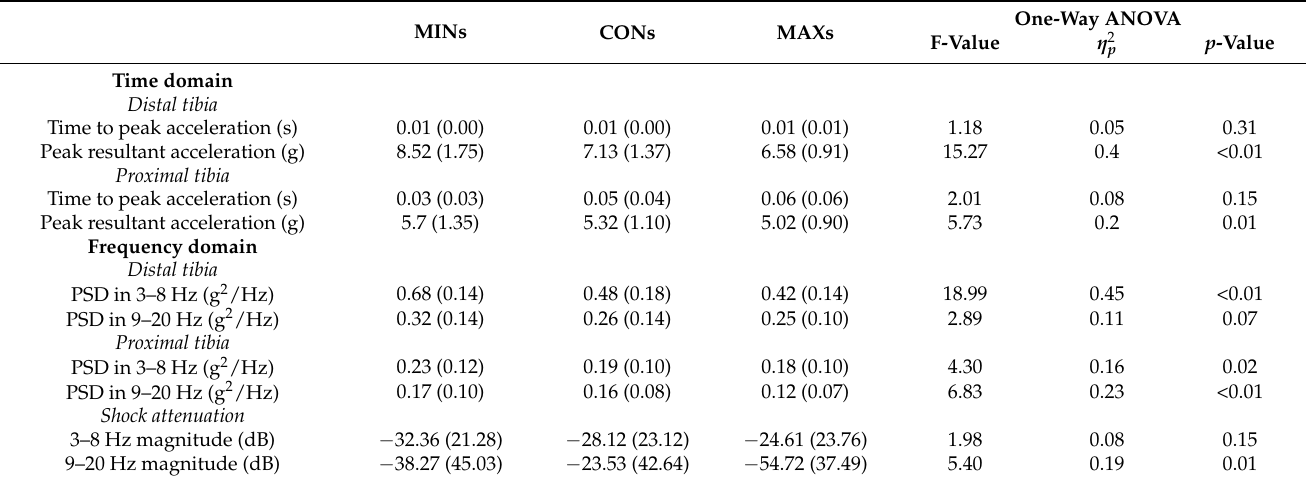
Table 1. Tibial acceleration analysis in the time and frequency domains with different running shoes (data were presented in mean (SD)). MINs CONs MAXs